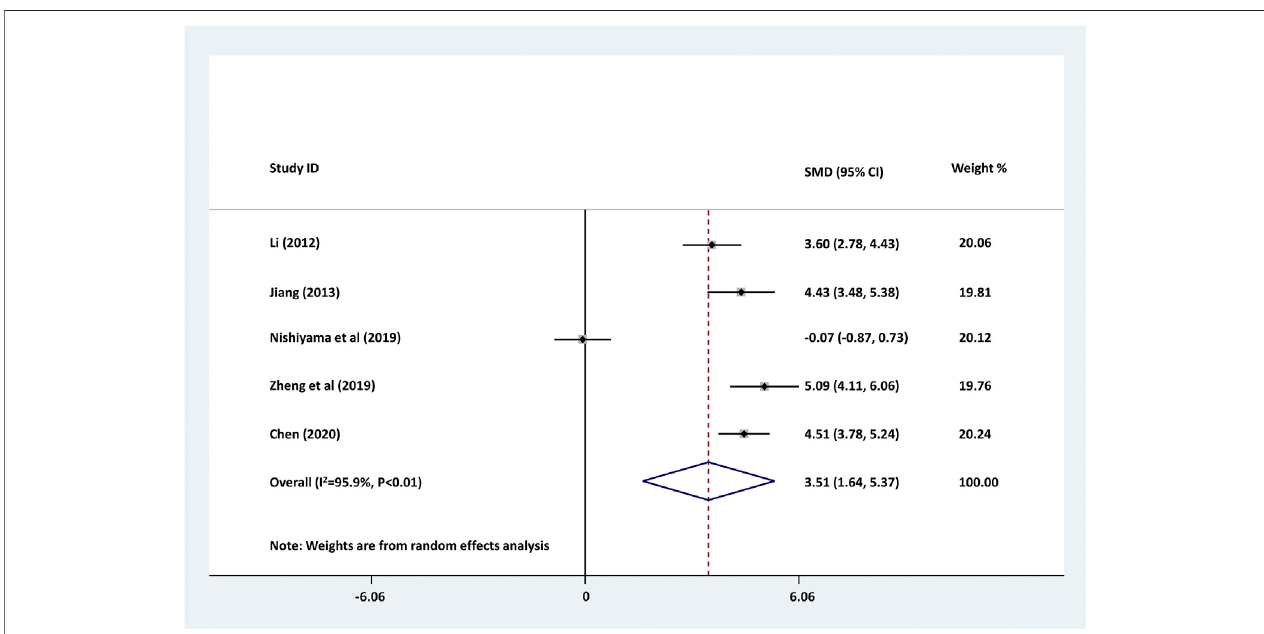
FIGURE 3 | Forest plot of studies detecting the serum changes of CRP levels before and after the treatment of levetiracetam in childhood epilepsy. Decreased serum CRP was found in childhood epilepsy treated with levetiracetam. The between-study heterogeneity was large ( τ 2 = 4.346, Chi 2 = 97.17, df = 4, p < 0.01, I 2 = 95.9%).